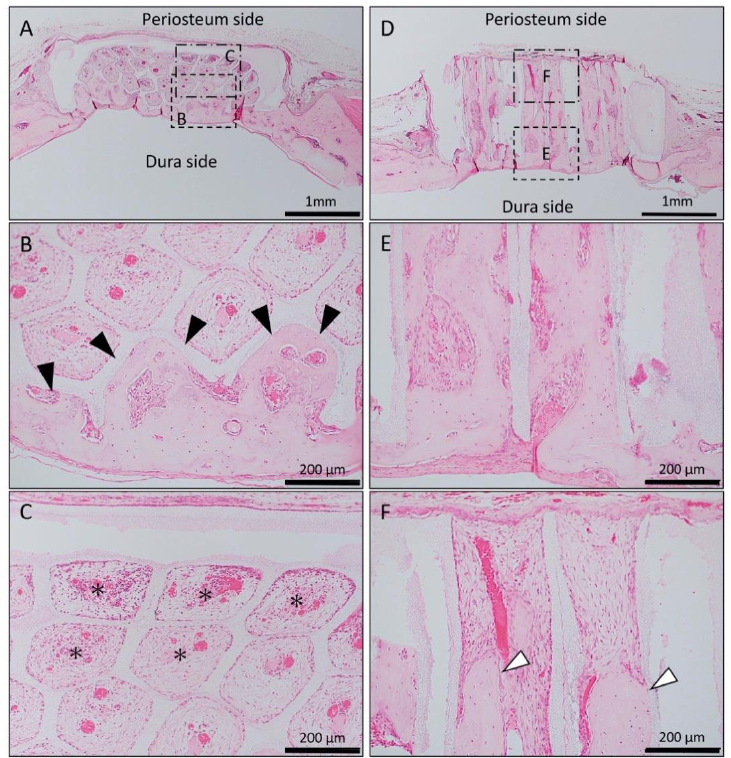
Figure 2. Histological images of β-TCP with Matrigel alone at 4 weeks after implantation. ( A ) Low-magnification image of horizontal β-TCP. No inflammatory granulation tissue was observed around β-TCP. ( B,C ) Higher-magnification image of corresponding outlined area in (A). Inflammatory cell infiltration was poor in all TCP holes, and vascular invasion was observed. Bone tissue formation was found only in the lower layer adjacent to the dura (black arrowheads), and no bone tissue was found in the periosteal side holes (asterisks). ( D ) Low-magnification image of vertical β-TCP. No inflammatory granulation tissue was observed around β-TCP. ( E,F ) Higher-magnification image of corresponding outlined area in (D). Bone formation was observed up to the upper part of the TCP holes (white arrowheads). In the Matrigel-loaded (with BMP-2) horizontal honeycomb β-TCP, new bone formation extended to the upper part of the holes and was observed from the dura side to the periosteum side as added to the inner walls of the holes; however, the bone formation ability was weak compared to the vertical honeycomb β-TCP group (Figure 3A–C). In the Matrigel loaded (with BMP-2) vertical honeycomb β-TCP, vigorous new bone formation was observed up to the upper part along the TCP holes, and almost all vertical holes were filled with vigorous new bone tissue. In addition, the formation of bone marrow-like tissue and vascular cavity were observed in the area surrounded by the bone tissue (Figure 3D–F).